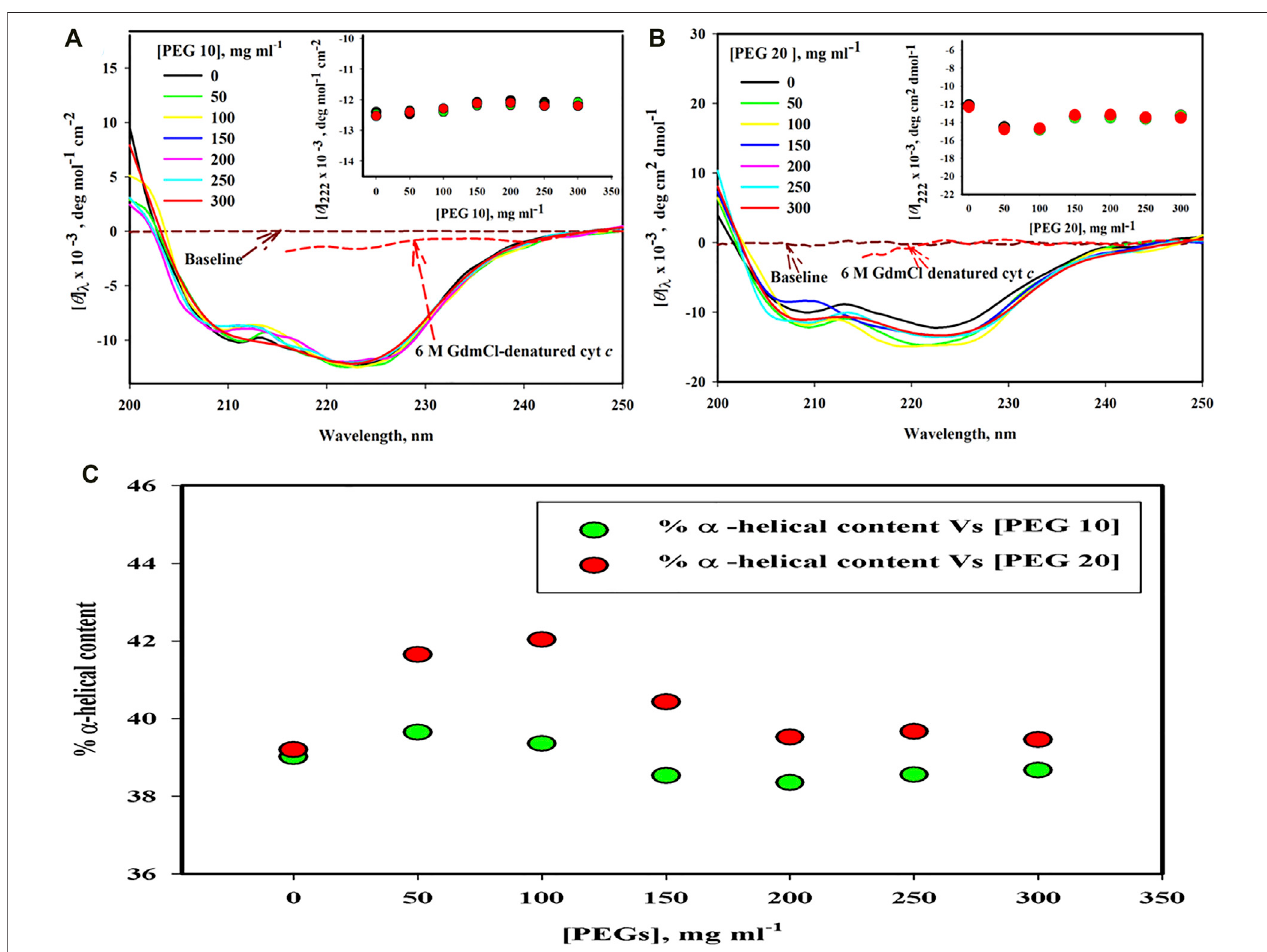
FIGURE2| Far-UVCDspectraofcyt c inthepresenceofvarious concentrationsof (A) PEG10and (B) PEG20.InsetofFigure (A) givesplotof[ θ ] 222 against [PEG 10]. InsetofFigure (B) givesplot[ θ ] 222 against [PEG20]. (C) α -helicalcontentmeasuredfrom[ θ ] 222 values offar-UVCDspectraofthecyt c intheabsenceand presence of various concentrations of PEGs 10 and 20.